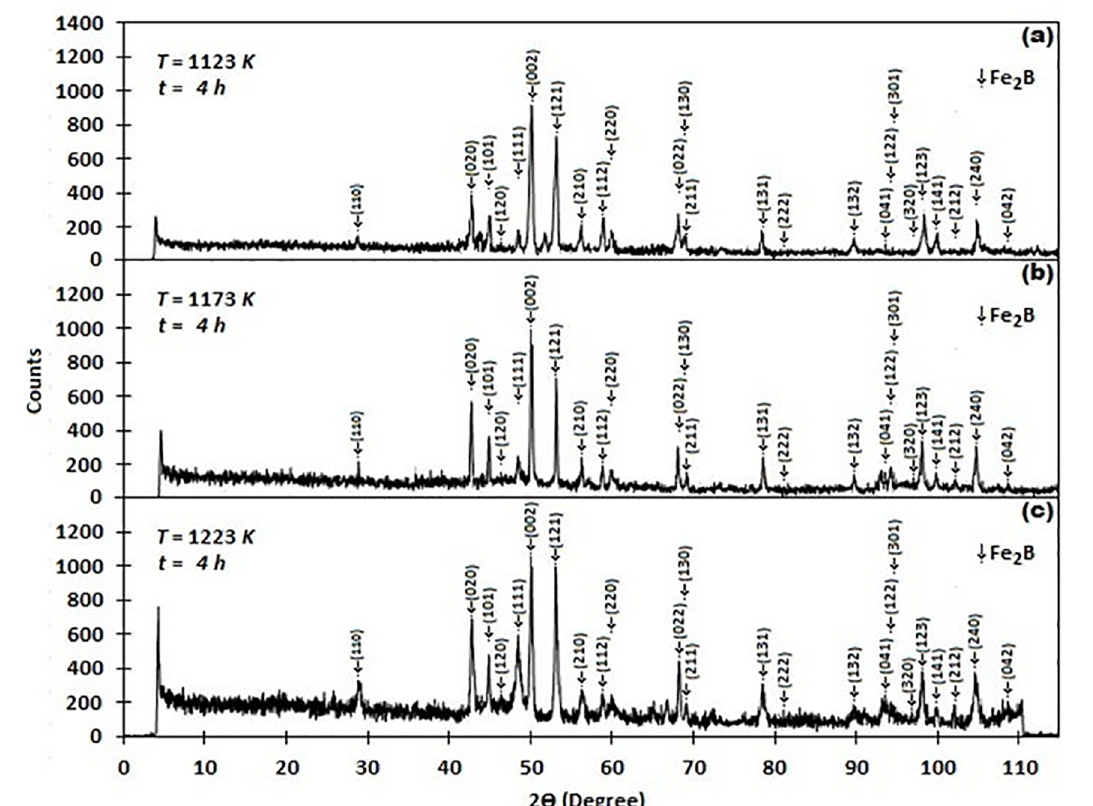
Figure 6. XRD patterns obtained at the surface of borided AISI S1 steels for three boriding conditions: (a) 1123 K for 4 h, (b) 1173 K for 4 h and (c) 1223 K for 4 h